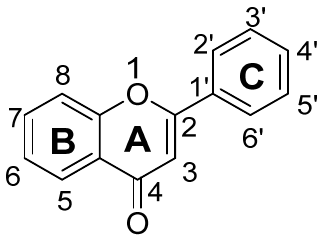
Figure 2. Skeleton of Flavones.